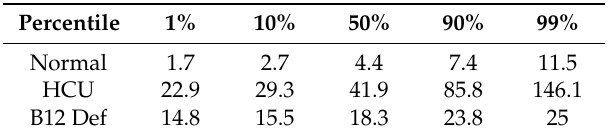
Table 2. The distribution * of tHCY, µmol/L, concentration of a normal population, classical homocystinuria patients, and patients with vitamin B12 deficiency expressed as population percentiles. Percentile 1% 10% 50% 90% 99% Normal